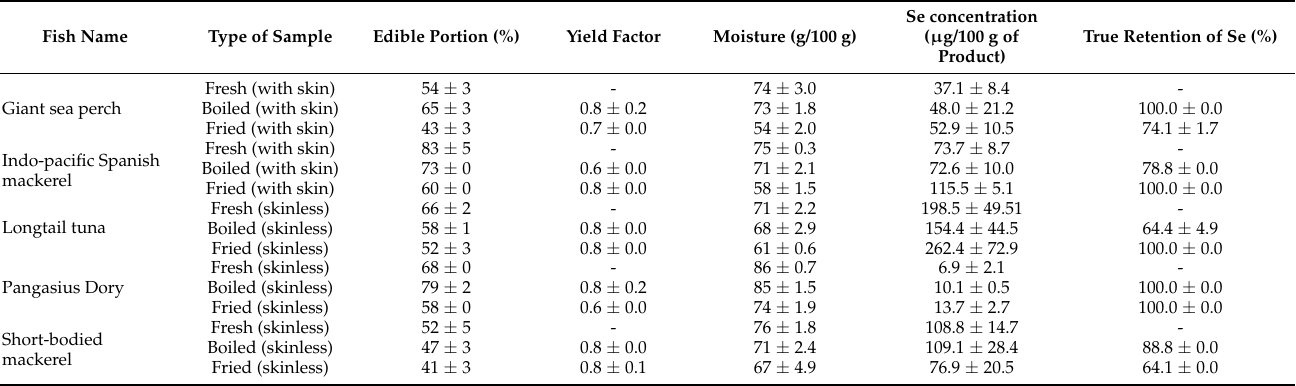
Table 4. Percentage of edible portion, yield factor, and moisture content of 3three individual sets from each type of marine fish, data expressed as mean ± SD ( n =